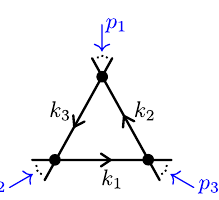
Figure 14: A trangle sub-graph with three independent masses m 2 = ( m ± m ) 2 the triangle is p 2 2 3 1